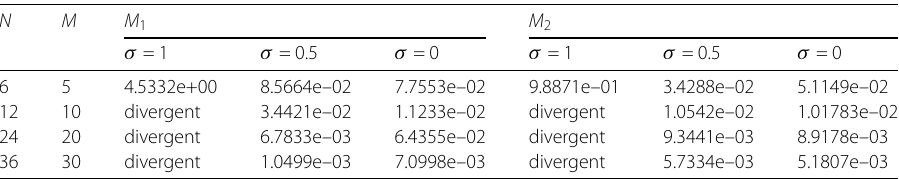
Table 4 Comparison of E 1 and E 2 , the maximum absolute errors, for different values of N , M in Example